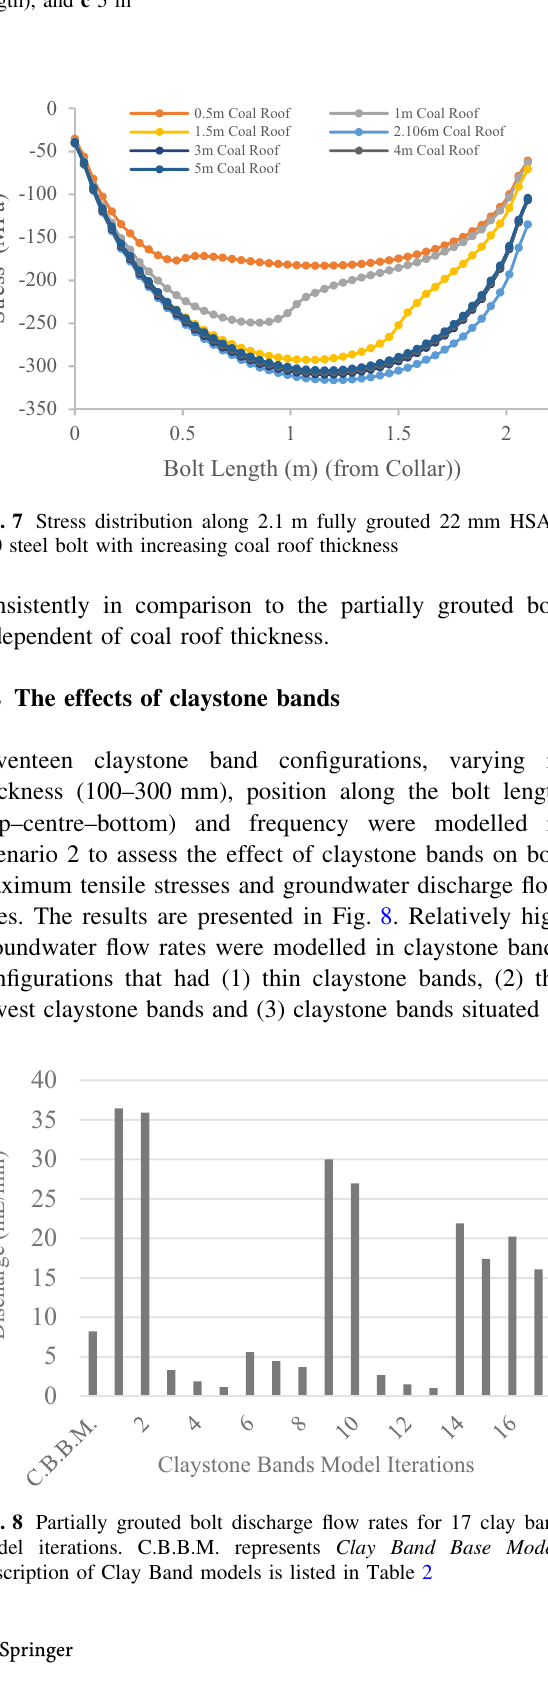
b Fig. 6 RS 2 schematic pore pressure output with flow lines for fully grouted bolts at various coal roof thickness. a 1 m, b 2.1 m (bolt length), and c 5 m